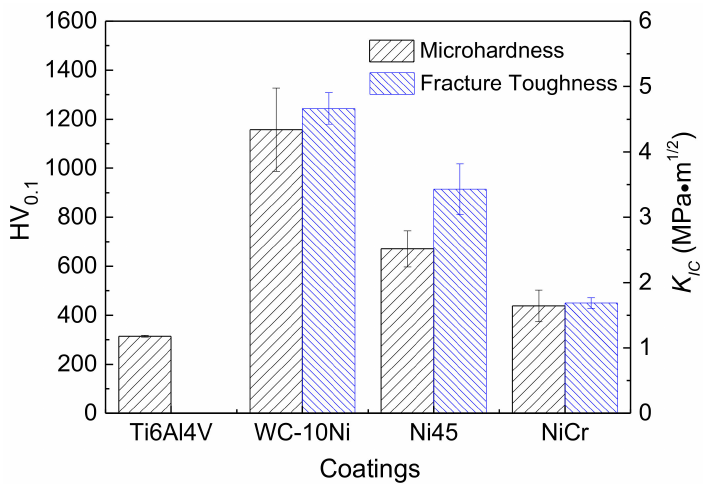
Figure 5. Microhardness and fracture toughness of the coatings.